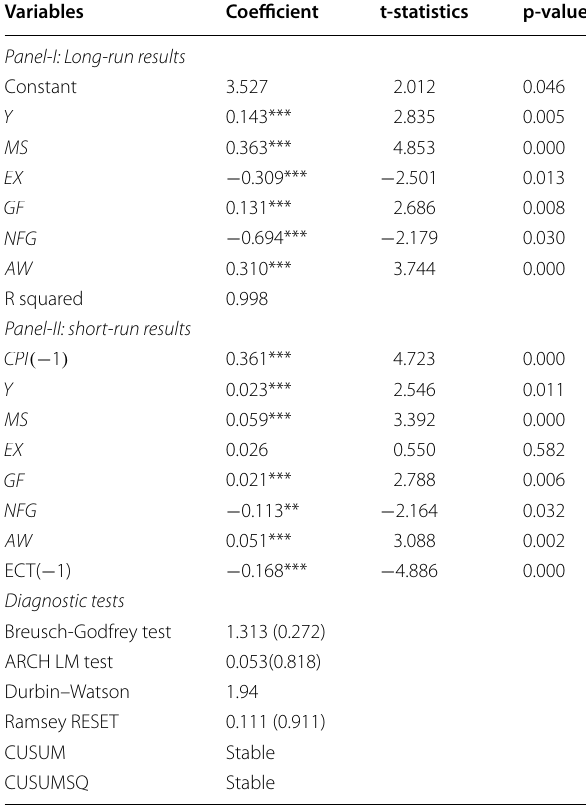
*, ** and *** indicate significance at the 10%, 5% and 1% levels, respectively. Source: Authors’ estimations